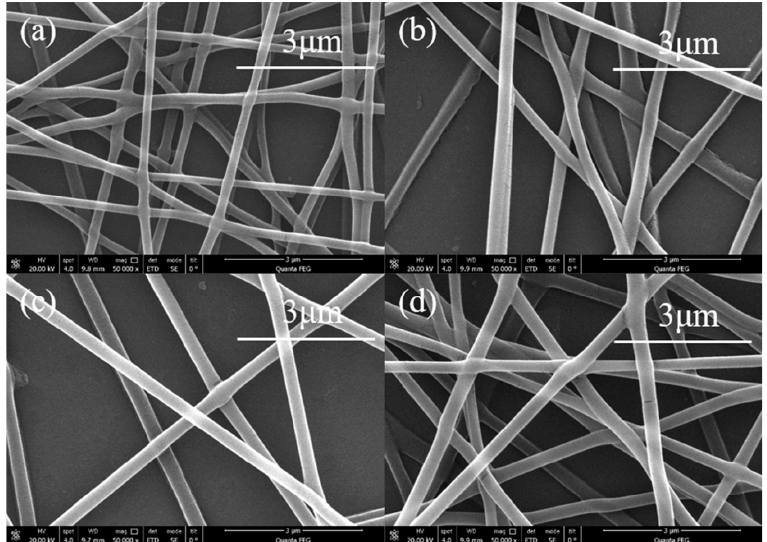
Figure 4. SEM image of PVA electrospinning nanofibers with different concentration. ( a ) 0.06 g/ml ( b ) 0.07 g/ml ( c ) 0.08 g/ml ( d ) 0.09 g/ml. ( b ) 0.07 g / mL ( c ) 0.08 g / mL ( d ) 0.09 g /